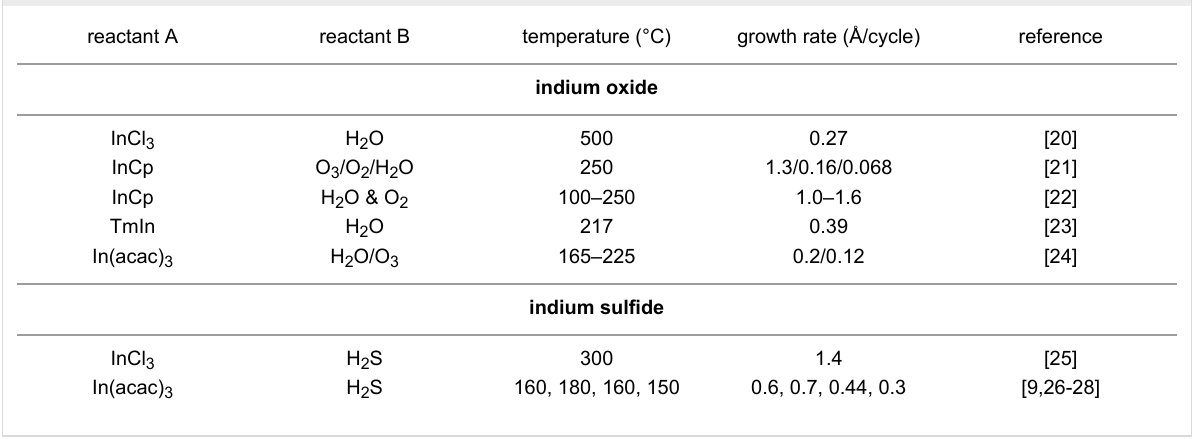
Table 1: Typical ALD processes for the deposition of In 2 O 3 and In 2 S 3